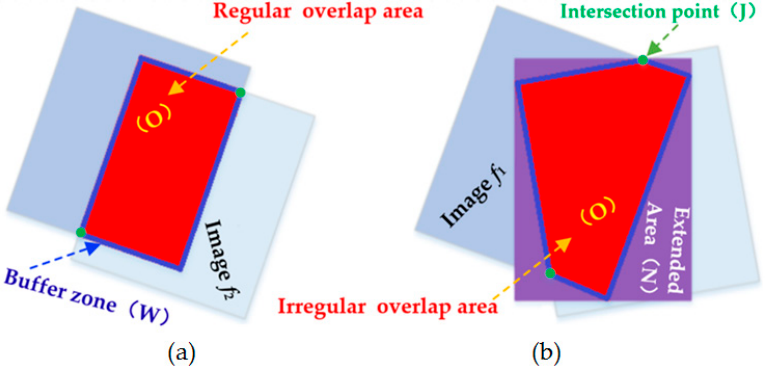
Figure 6. Processing principle of different images overlap area: ( a ) Regular overlap area; ( b ) Irregular overlap area.